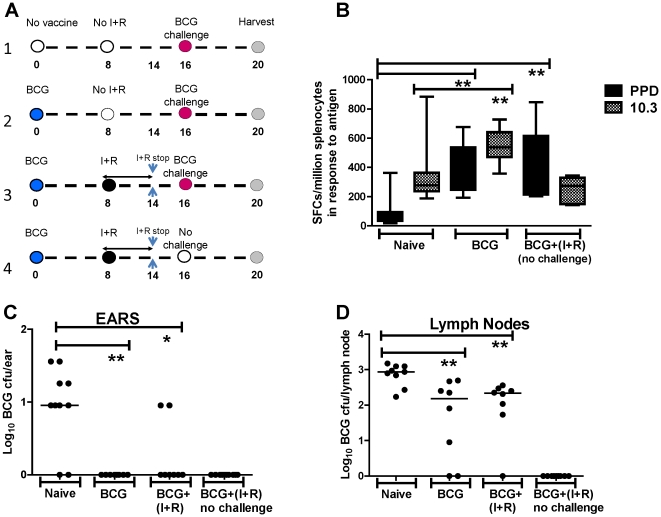
Effect of BCG immunization on a 16-week id BCG challenge.Timeline is shown in (a). BALB/c mice were immunized id with 1×104 CFU BCG. Naïve mice received no immunization. 16 weeks later all mice were challenged with 103 CFU BCG, except the (BCG+(I+R)(no challenge)) group. This group and the BCG+(I+R) group received 6 weeks of isoniazid and rifampicin (starting 8 weeks post initial BCG immunization). In the BCG+(I+R) group, there was a 2 week wash-out period between cessation of antibiotics and subsequent BCG challenge. (b) shows the splenic IFN-γ ELISpot responses to PPD and TB10.3, in naïve, BCG-vaccinated, and BCG+(I+R)(no challenge) animals, 4 weeks post BCG challenge. Whiskers represent minimum to maximum values, boxes the interquartile range, and the bars the median values for each group (*P<0.05, **P<0.01, “non-significant”, ND. n = 10, except for BCG+(I+R); n = 2). Ears and LNs were harvested 4 weeks after BCG challenge and processed for CFU quantification. Log10 BCG CFU of challenge are shown, for groups 1 (Naïve), 2 (BCG) and 3 (BCG+(I+R)). For group 4 (BCG+(I+R) no challenge), the ear and LN CFU correspond to the CFU remaining from the priming BCG immunization (zero in all animals). Individual data points for each mouse are shown. Bars represent the median per group. (c) Ears (*P<0.05,**P<0.01, n = 10); (d) LNs (**P<0.01, n = 10).